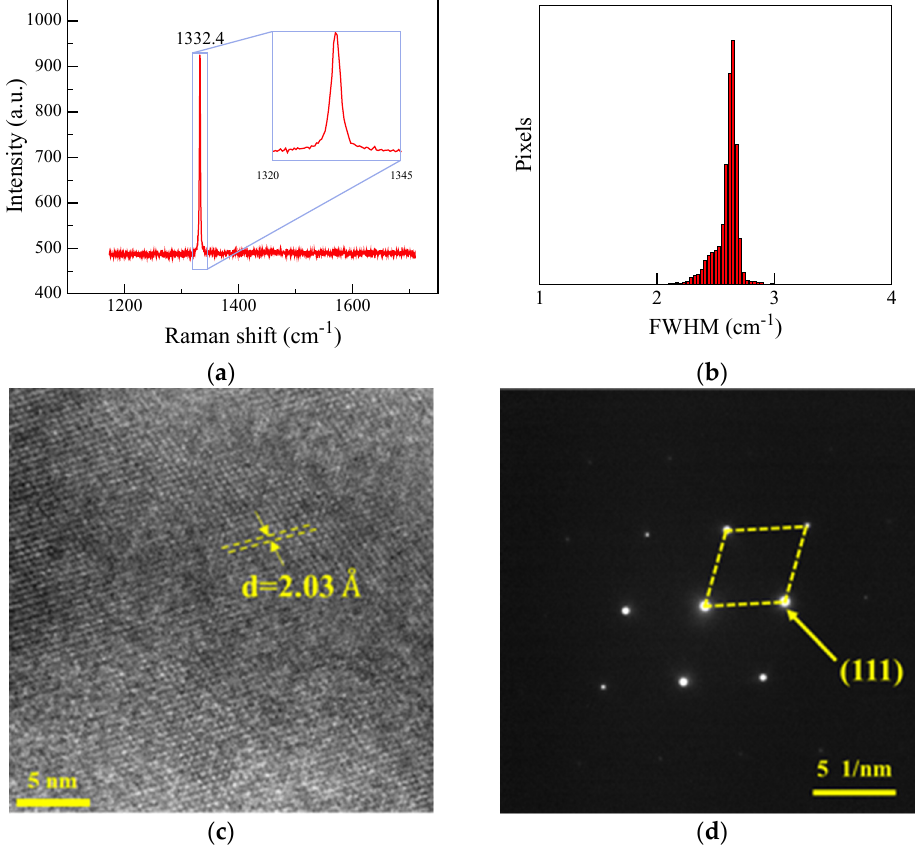
Figure 1. ( a ) Raman spectrum, ( b ) full width at half maximum image, ( c ) high-resolution transmission electron microscope image, ( d ) selected area electron diffraction image of the SCD substrate.